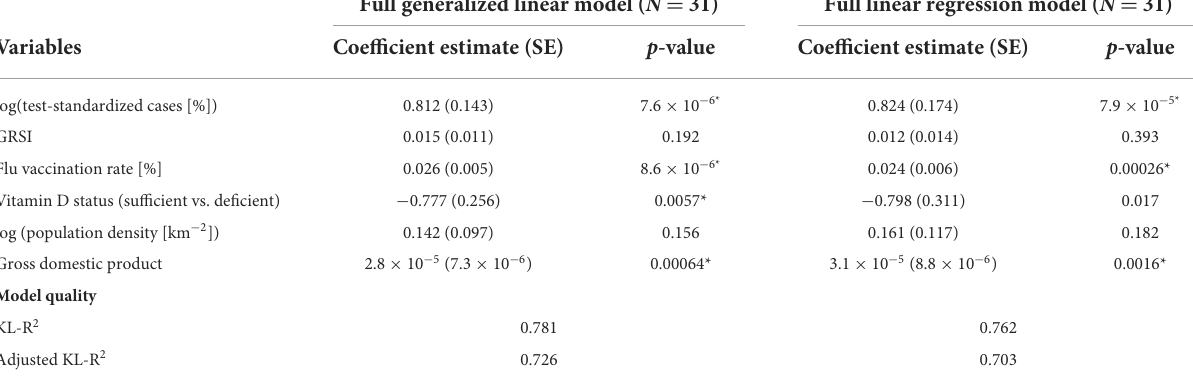
TABLE 3 Results of the full generalized linear models fitted to the original dataset with missing variables removed (intercept not